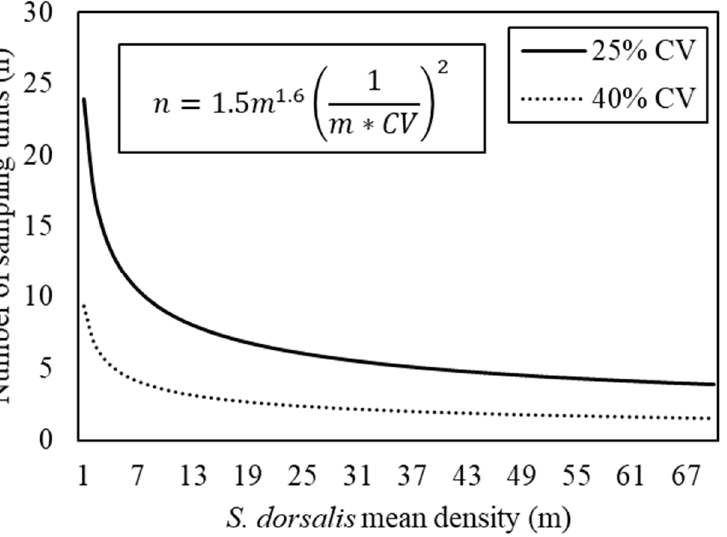
Figure 4. Number of sampling units ( 𝑛 ) required to estimate the S. dorsalis mean density ( 𝑚 ) in Florida blueberry fields with variable coefficients of variation ( 𝐶𝑉 ) calculated by modeling Taylor’s power law parameters into the mathematical formula: 𝑛 = a ∗ m (cid:3029) (cid:4666)1 𝑚⁄ ∗ 𝐶𝑉(cid:4667) (cid:2870) .